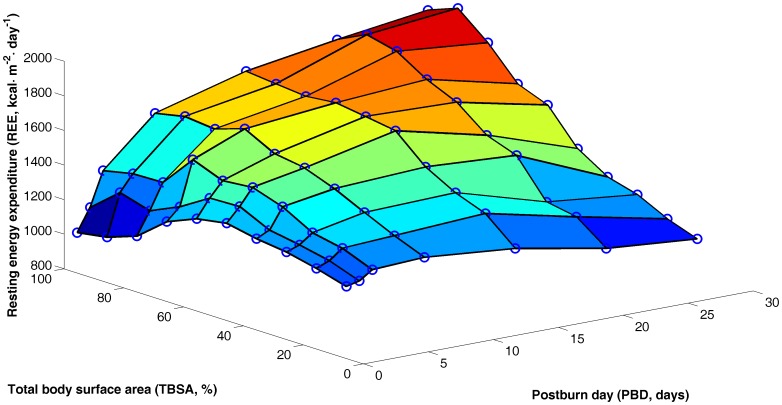
Three-dimensional display of the average REE data of burned patients plotted vs. TBSA and PBD.Circles represent average REE measurements.